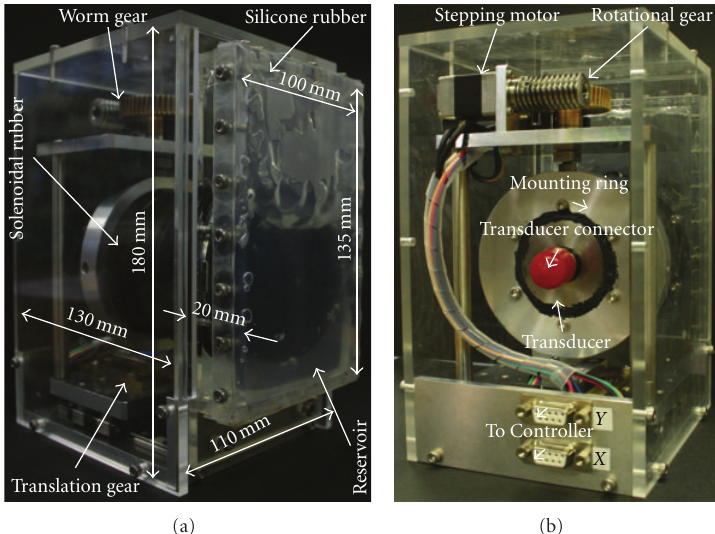
Figure 2: (a) The front view of the probe. Mounting ring holds the ultrasonic transducer to mount it on rotational mechanism. The rotational and translational motions are actuated by worm gear and translational gear. (b) The back view of the